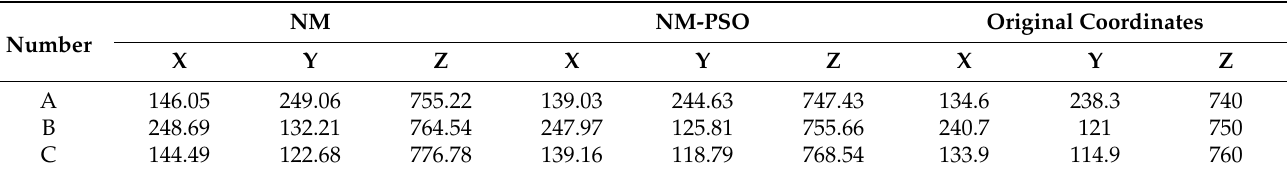
Table 5. Positioning results of each